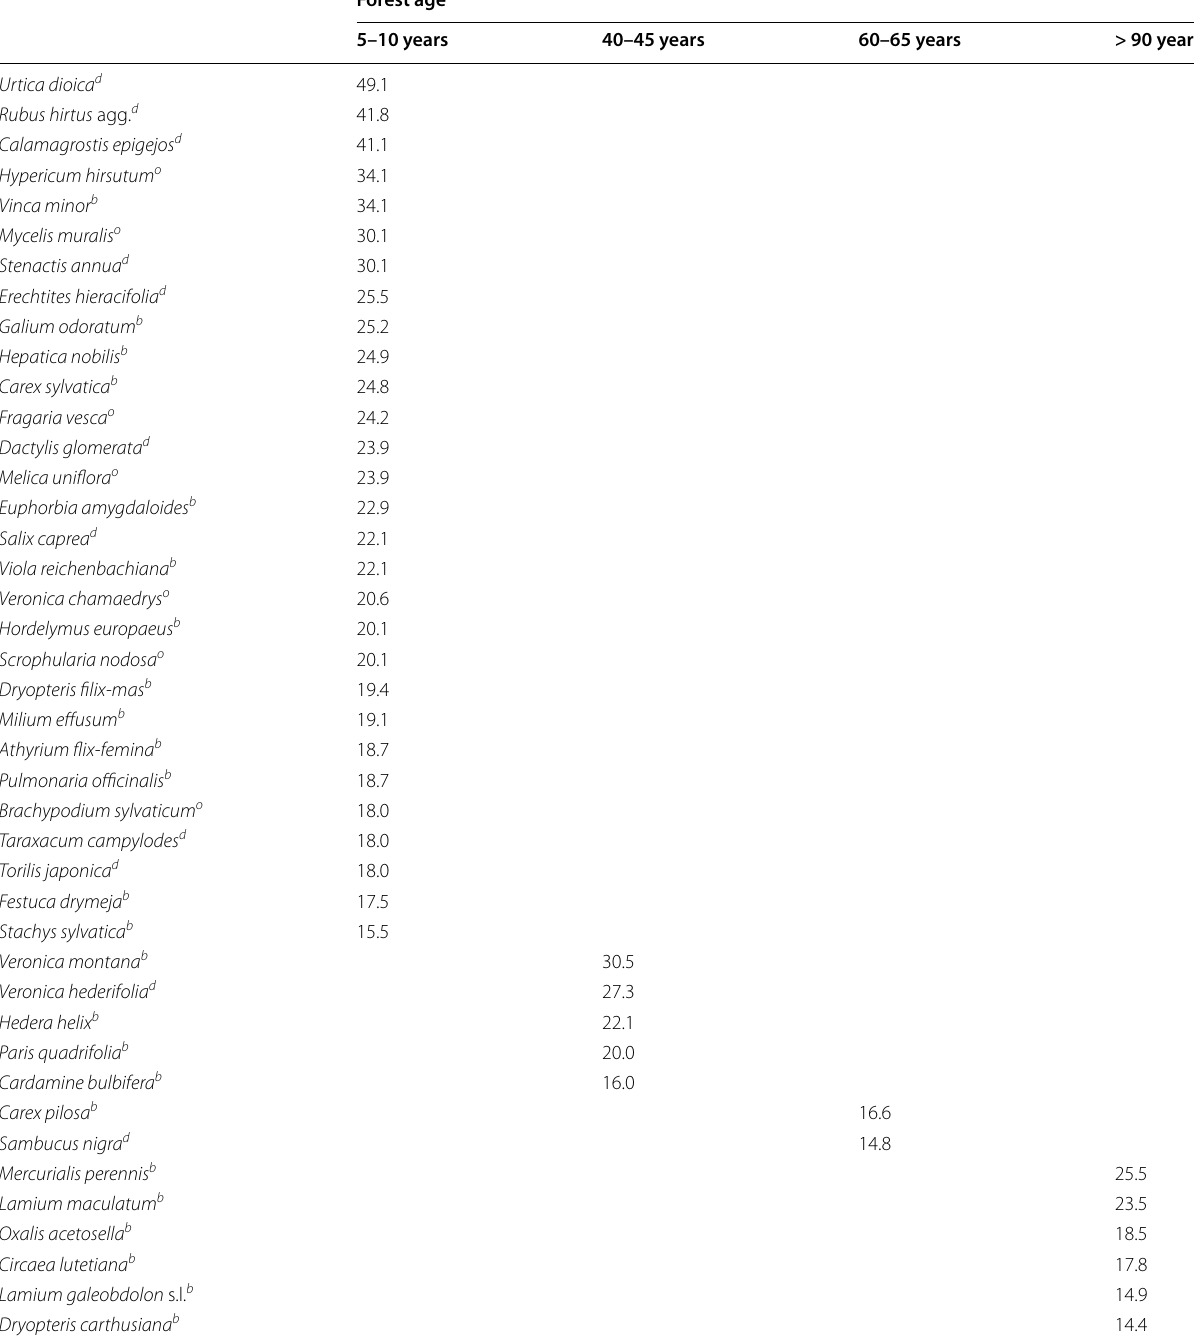
Table 1 List of diagnostic species for the forest age classes (class 1: 5–10-year-old forest stands with mature forest patches, class 2: 40–45-year-old forests, class 3: 60–65-year-old forests, and class 4: more than 90-year-old forests) in dolines. Within blocks, species are listed by decreasing values of the phi (Φ) coefficient. Fidelity values (Φ 100) of beech forest species, oak forest species, and species of × disturbed forests are indicated with superscripts b, o, and d, respectively. Non-diagnostic species were excluded with Fisher’s exact test ( p <